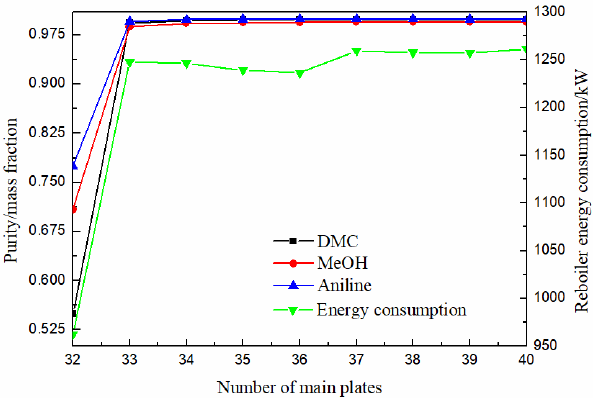
Figure 5. Effect of number of main plates on product purity and heat duty of reboiler.